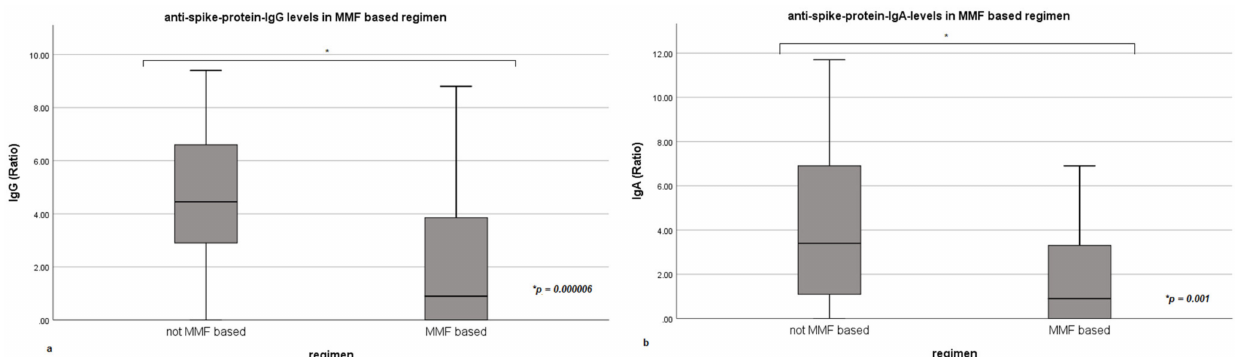
Figure 3. Influence of mycophenolate mofetil (MMF)-based immunosuppression on anti-spike-protein-IgG- and IgA-levels as box plots. ( a , b ) show the influence of mycophenolate mofetil based immunosuppression on anti-spike-protein-IgG- and IgA-levels. Ratio = dimensionless unit; quotient of the extinction value of the patient sample and the calibrator. Box plots present means, interquartile range (IQR), minimum and maximum with each individual bar.